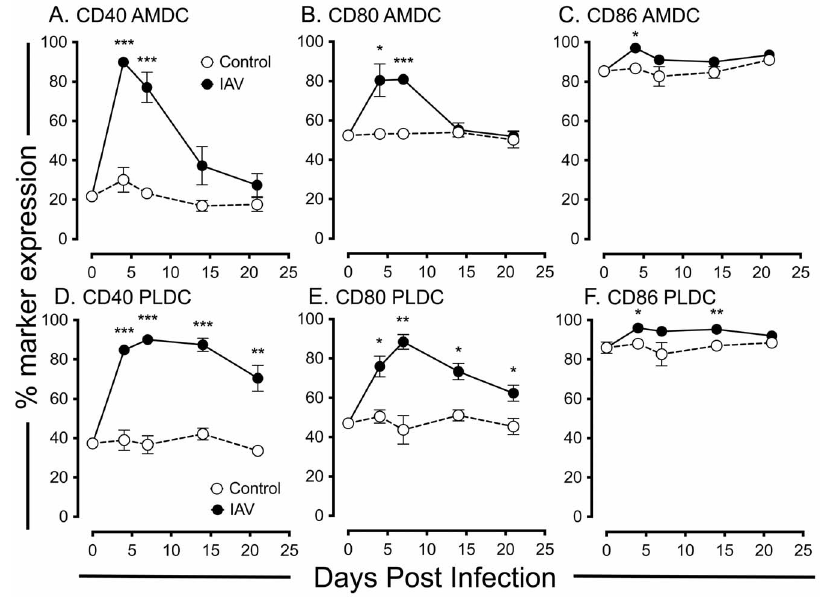
Figure 6. Expression of the co-stimulatory molecules CD40, CD80 and CD86 on respiratory DC subsets in anatomical compartments of the respiratory tract following IAV infection. (A–C) Time-course of expression of CD40 (A), CD80 (B) and CD86 (C) on AMDC expressed as a percentage of cells expressing each marker of the total AMDC population (gated as per Fig. 4A). (D–F) Time-course of expression of CD40 (D), CD80 (E) and CD86 (F) on PLDC expressed as a percentage of cells expressing each marker of the total PLDC population (gated as per Fig. 4D). Data are means + / 2 SEM for 3 independent infection experiments using pools of tissue from 3 to 4 mice for each experiment. The percentage expression of each marker was calculated based on histogram gates set using matching isotype control antibodies for each marker (Fig. S2) * = p , 0.05; ** = p , 0.01; *** = p , 0.001.